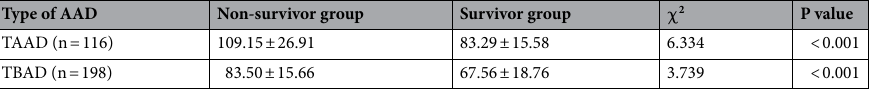
Table 4. IMA in non-survivor and survivor groups between TAAD and TBAD patients. AAD, acute aortic dissection; TAAD, Stanford type A aortic dissection; TBAD Stanford type B aortic dissection; IMA, ischemic modified albumin.